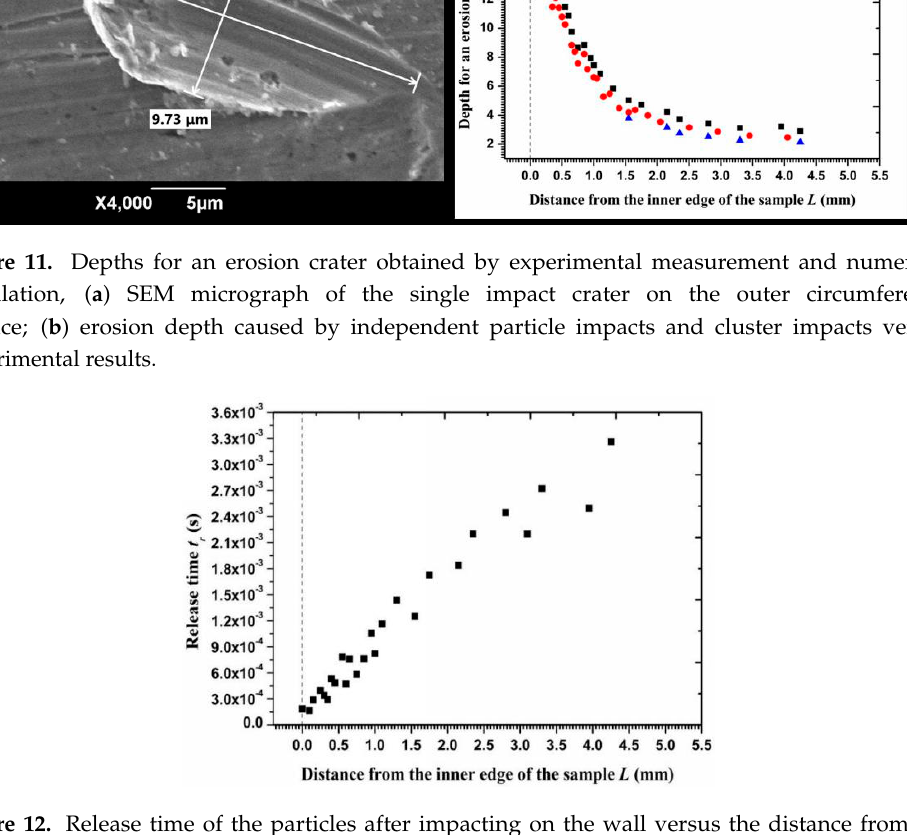
Figure 12. Release time of the particles after impacting on the wall versus the distance from the inner edge.